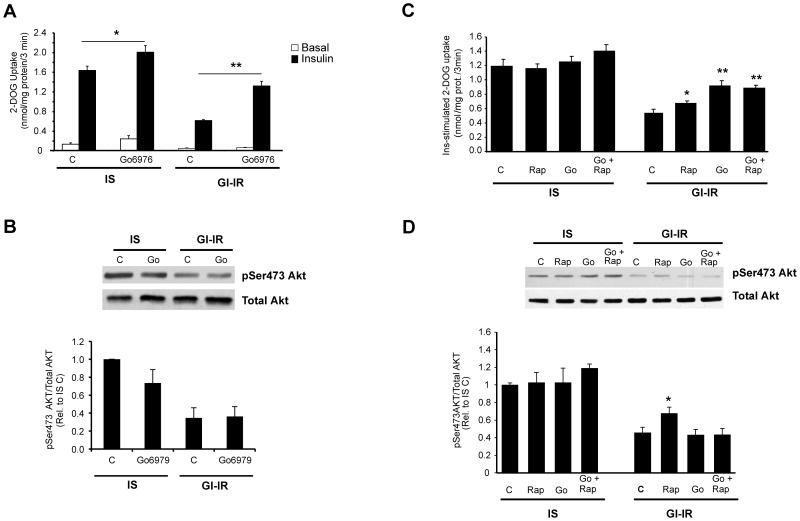
Treatment with Go-6976, reverses hyperglycemia-induced insulin resistance in adipocytes.
A. Effect of Go-6976 on Glucose transport. Insulin sensitive (IS) Adipocytes were preincubated in 5 mM glucose while Glucose-induced insulin resistant, (GI-IR) were generated by preincubation in 25 mM glucose+0.6 nM insulin for 18 h. During serum and insulin deprivation for 2 h, adipocytes were received 0.3 mM Go-6976 or vehicle control during the last hour of incubation. Glucose (2DOG) uptake was determined in unstimulated (open bars, basal) or in insulin-stimulated (100 nM for 15 min; filled bars, Insulin) cells. B. Effect of Go-6976 on insulin-stimulated Akt phosphorylation. Adipocytes were treated as in A, following acute insulin stimulation, cell lysates were collected and both phospho-Akt and total AKT was measured. Quantification represents ratios of phosphoAKT/Total AKT protein expressed relative to ratios obtained in from control insulin sensitive (IS) adipocytes. C. The effects of rapamycin and Go-6976 on insulin-stimulated glucose transport. Adipocytes were treated as in A, except that only cells, which have been acutely stimulated with insulin, are shown. Go-6976 (0.3 mM) and rapamycin (100 nM) are added during the last hour of incubation. D. The effects of rapamycin and Go-6976 on insulin-stimulated Akt phosphorylation. Adipocytes were treated as in C, following acute insulin stimulation, cell lysates were collected and both phospho-Akt and total AKT was measured. Quantification represents ratios of phosphoAKT/Total AKT protein expressed relative to ratios obtained in from control insulin sensitive (IS) adipocytes. Statistical significance is indicated by *p<0.05, and ** = p<0.005 compared to controls with the same preincubation.